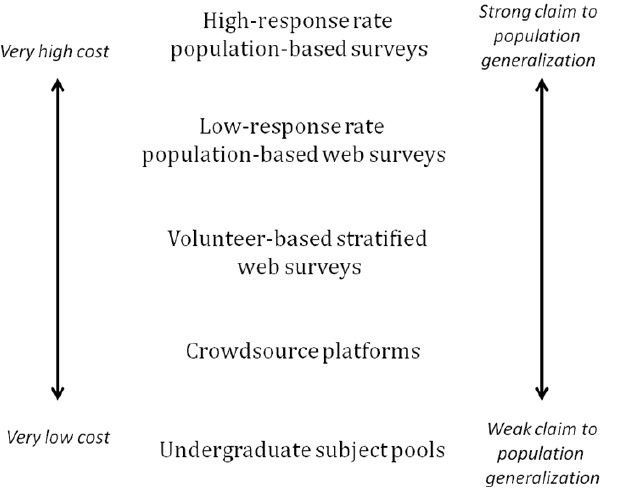
Figure 1: Hierarchy for Survey Platform by Cost and Generalizability in population estimates cannot be addressed by